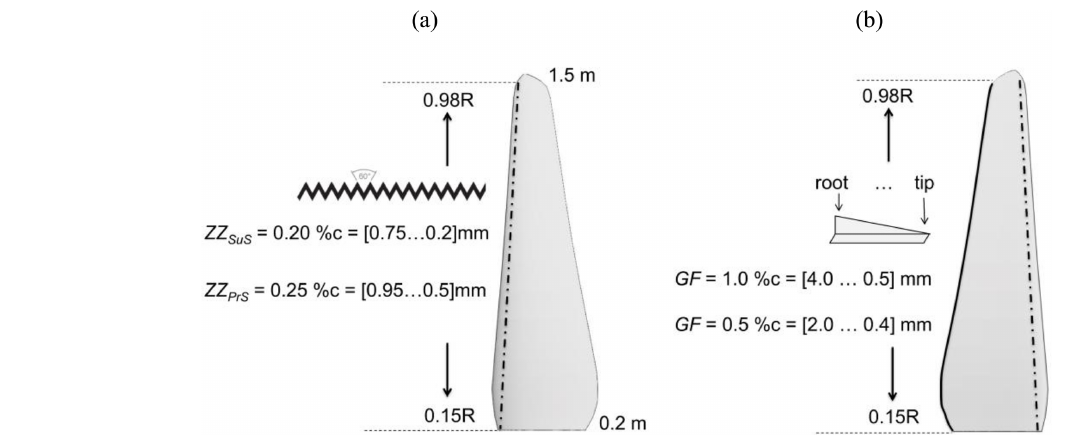
Figure 4. (a) Zigzag tape at the leading edge of the suction side. (b) Gurney flap and ZZ tape at the pressure side of the trailing edge.